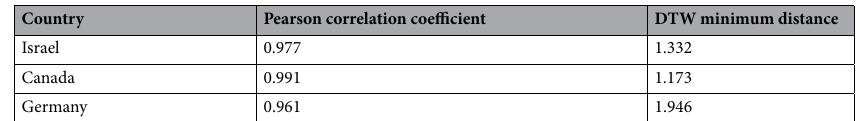
Table 1. Correlation between the deconvoluted trends in daily cases and deaths in Israel, Canada, and Germany during the second wave of the COVID-19 pandemic.